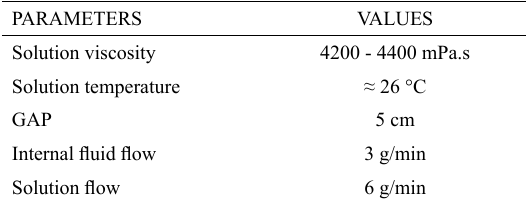
Figure 1 . Schematic representation of the process to obtain hollow fiber membranes by spinning Table 2. Spinning conditions of hollow fiber membranes.